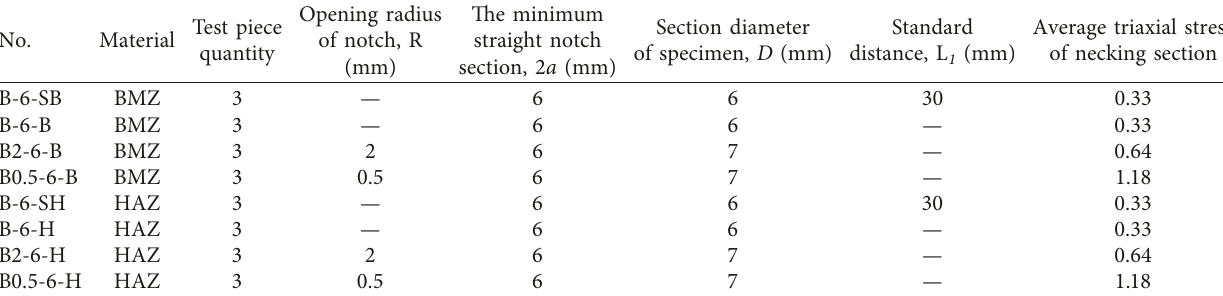
Table 1: The specimens of round